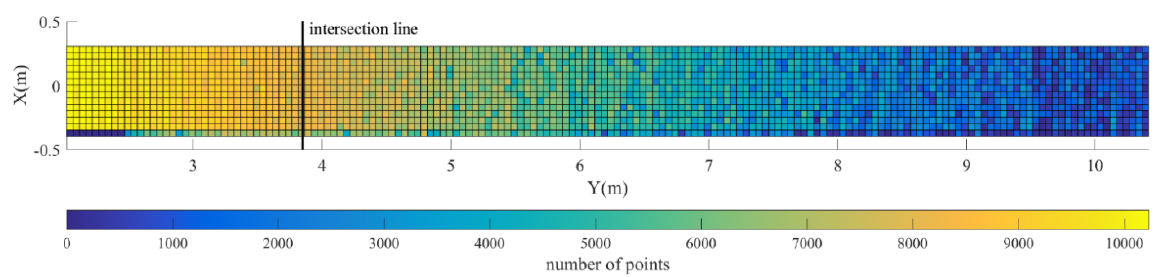
Figure 7. Raster image colored by pixel change for both slopes ( top for slope 1 and bottom for slope 2). A pixel change value is obtained by differencing the mean of the Z values for the corresponding pixel in two epochs. Negative pixel change values indicate that erosion happened in a pixel while positive pixel change value indicates. Note that the area covered by Slope 1 is longer as the slope grade is more gentle and therefore covers a longer area.